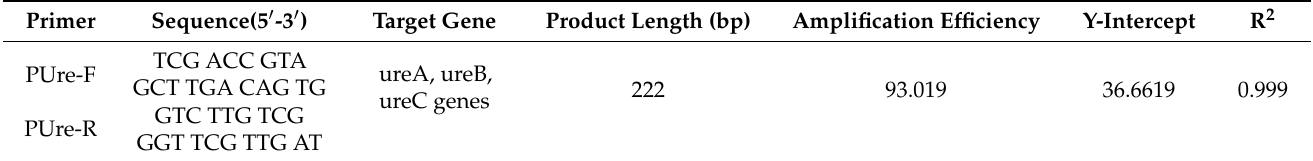
Table 3. Target gene and primer sequence for quantitative